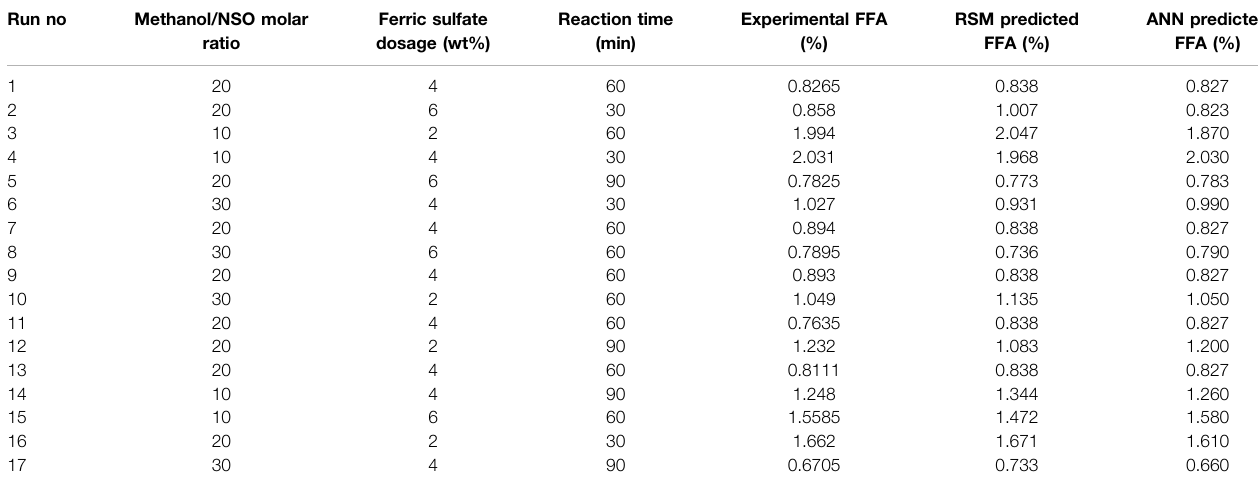
TABLE 5 | Design matrix, experimental and predicted values of %FFA. Run no Methanol/NSO molar